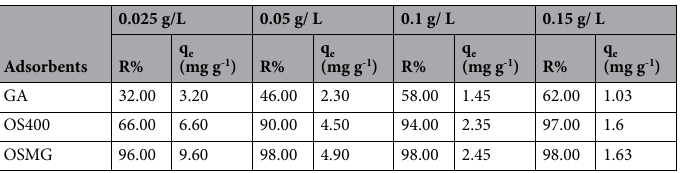
Table 3. Effect of adsorbent dose on R(%) and q e (mg. g −1 ) of MB dye after 100